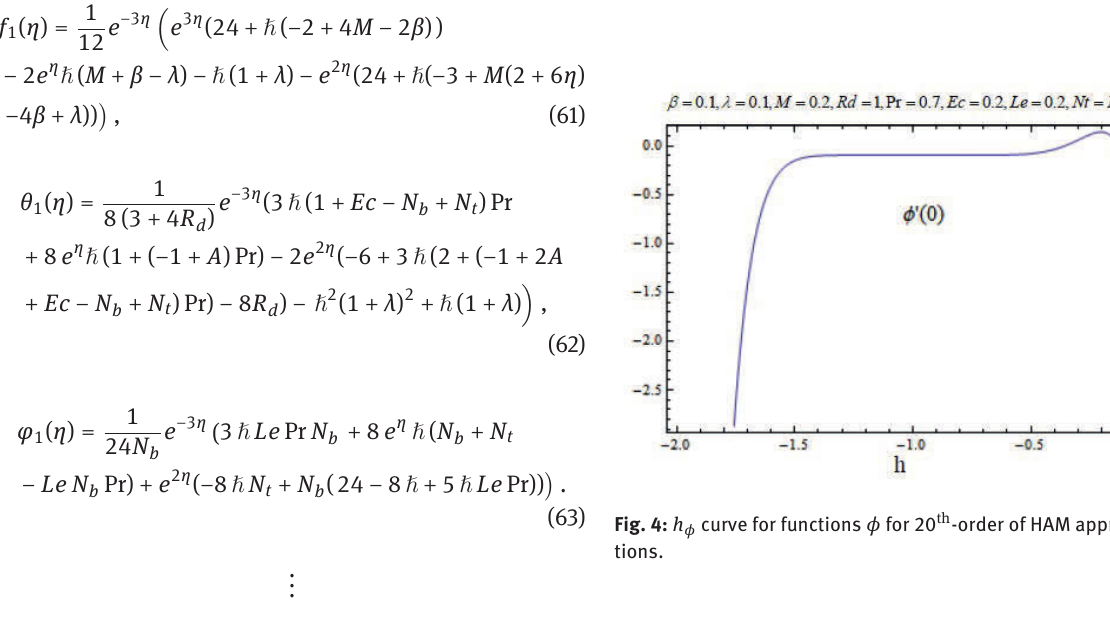
Fig. 3: h θ curve for functions θ for 20 th -order of HAM approxima- tions.